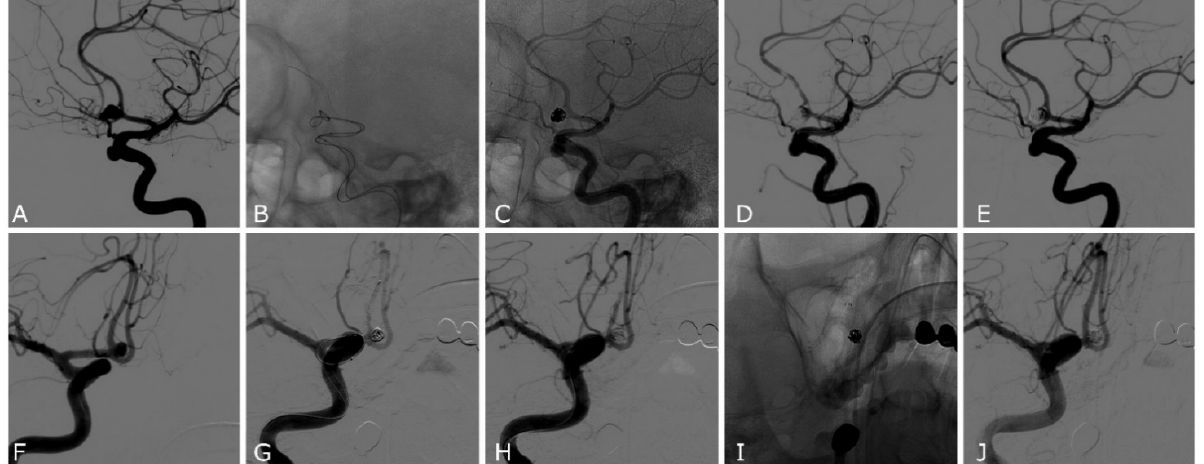
Figure 2. Patient number 11 ( A – E ): ruptured ACOM wide-neck aneurysm. ( A ) Lateral oblique 2D DSA demonstrating the ACOM aneurysm with a daughter sac pointing anteriorly. ( B , C ) Unsubtracted image showing the expanded Comaneci device during the coiling. ( D ) Lateral oblique 2D DSA showing the clot formation between the meshes of the Comaneci device that required the infusion of Acetylsalicylic acid and Tirofiban. ( E ) Lateral oblique 2D DSA acquired 30 min after the infusion of Acetylsalicylic acid and Tirofiban demonstrating a complete resolution of the thrombotic complication and a neck remnant of the aneurysm. Patient number 12 ( F – J ): ruptured ACOM wide-neck aneurysm. ( F ) Anteroposterior oblique 2D DSA demonstrating the ACOM aneurysm. ( G ) Anteroposterior oblique 2D DSA demonstrating clot formation between the meshes of Comaneci device that required infusion of Acetylsalicylic acid and Tirofiban. ( H ) Anteroposterior oblique 2D DSA after removing the Comaneci device, showing the protrusion of the coils in the parent artery and thromboembolic occlusion of the right A2 segment of anterior cerebral artery, which was not yet responsive to medical treatment. ( I ) Unsubtracted image of the deployment of a rescue Atlas stent. ( J ) Anteroposterior oblique 2D DSA acquired 30 min after the infusion of Acetylsalicylic acid and Tirofiban, demon- strating the patency of the Atlas stent, the resolution of the clot, and the patency of both anterior cerebral